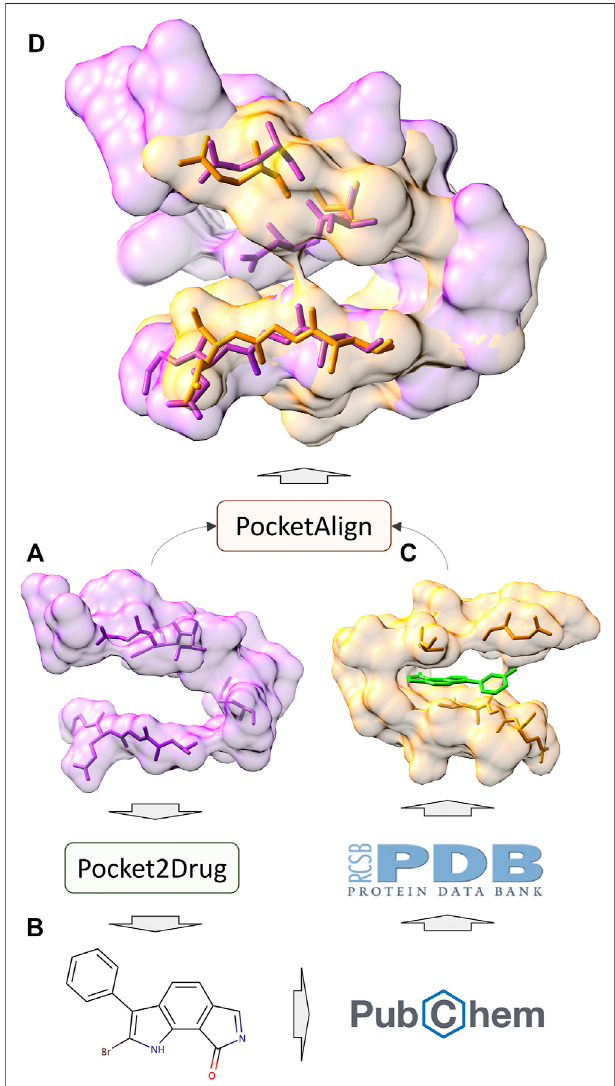
FIGURE 7 | Flowchart of the evaluation by pocket structure alignments. For a target pocket (A) , a molecule is generated by Pocket2Drug (B) . This compound is then scanned through the PubChem BioAssay for similar molecules forwhichexperimental complex structures are available in the Protein Data Bank. The extracted binding site (C) corresponding to the know interactioninPubChemBioAssayisstructurallyalignedtothetargetpocketby PocketAlign. A high-quality alignment (D) indicates that the generated molecule is likely to bind to the target pocket.